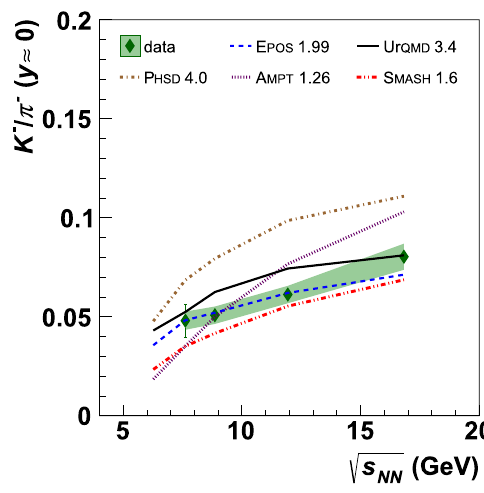
Fig. 37 Comparison of the energy dependence of K + / π + (left) and K − / π − (right) yields ratio at mid-rapidity for the 20% most central Be+Be collisions with models: Epos 1.99 (blue dashed line), U r qmd